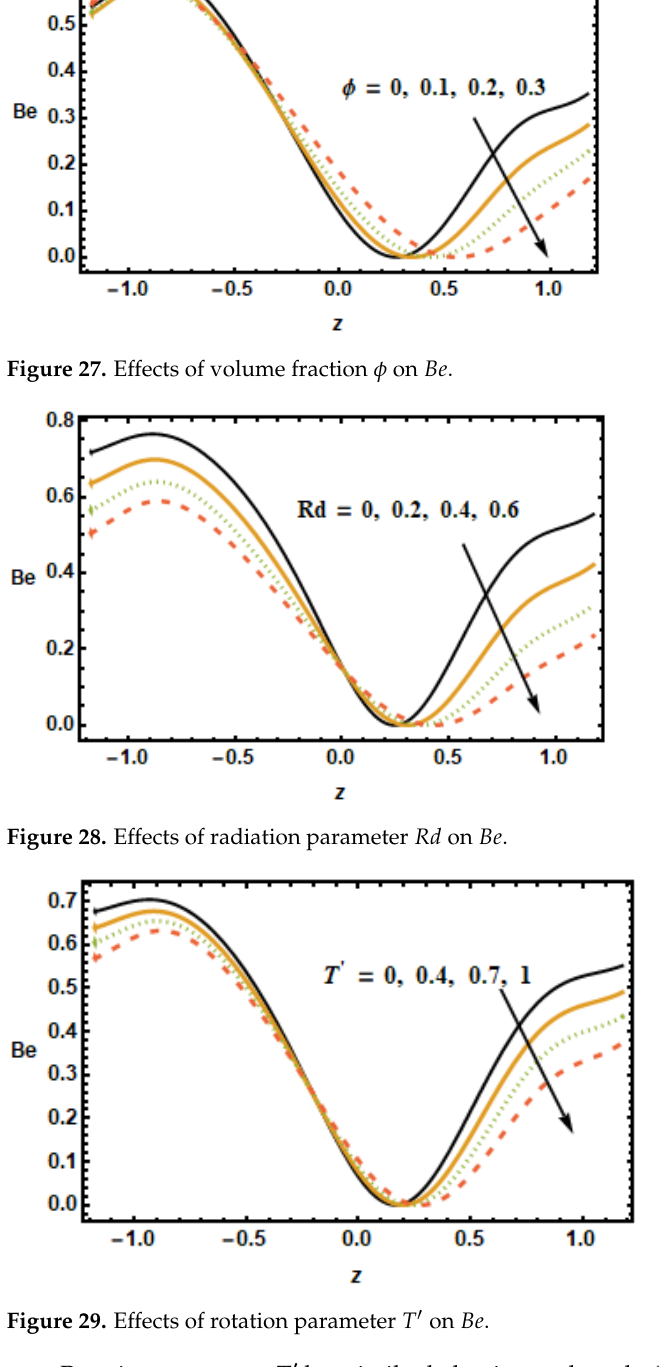
′ Figure 29. Effects of rotation parameter T (cid:48) on Be . T Figure 29. Effects of rotation parameter on Be . Rotation parameter T (cid:48) has similar behavior, such as the Hartman number M having an inverse relation with the Bejan number due to angular velocity across the boundaries of the channel. It is seen in Figure 30 that the heat flux parameter ε 1 increased the Bejan number Be along the boundaries, whilst the dependence remained constant in the center of the channel. The Bejan number had an increasing and decreasing trend for the Hall Effect and the volume fraction, respectively. Rotation, radiation and the Hartman number affected the Bejan number and entropy generation number in a similar manner. Furthermore,